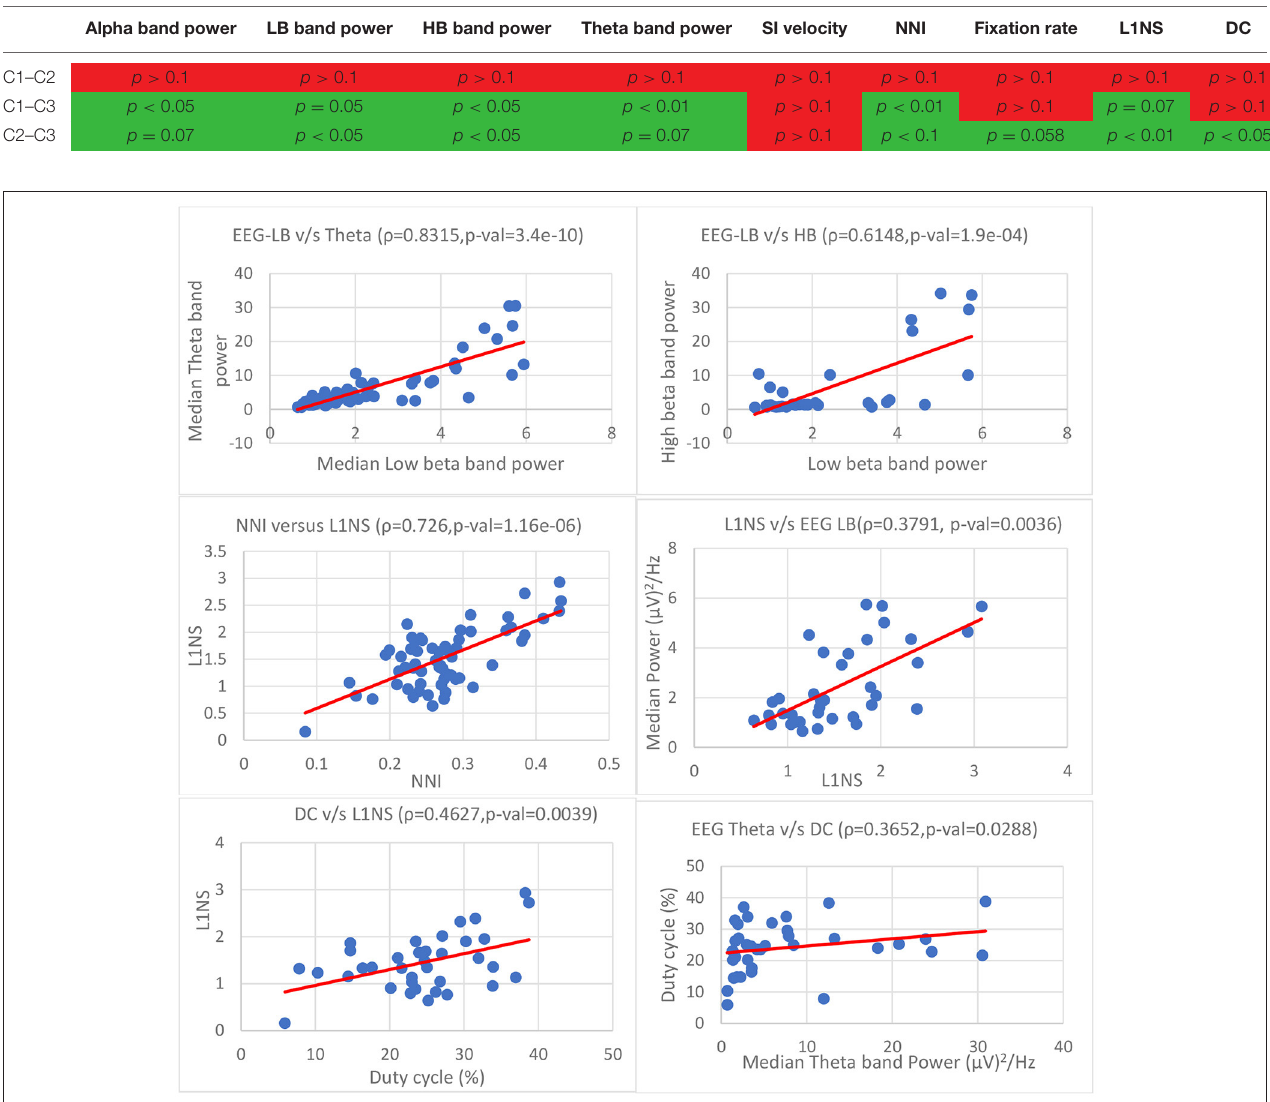
TABLE 13 | Comparison between parameters.